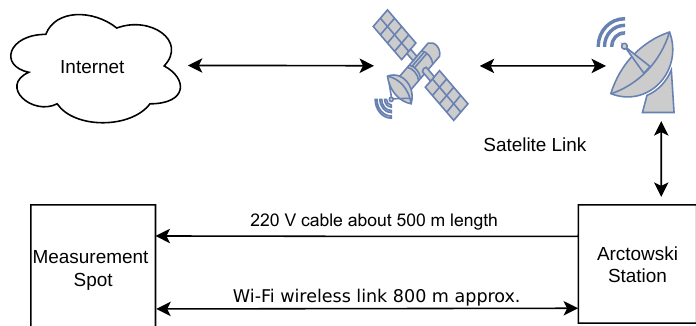
Figure 4. A global diagram of the custom network insertion into the Arctowski station infrastructure.